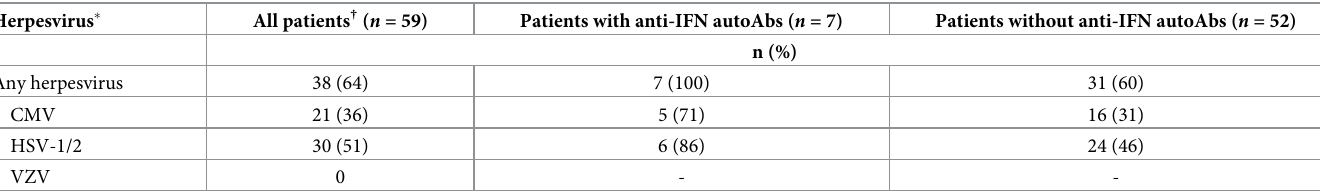
Table 3. Description of herpesvirus detection. Herpesvirus � All patients † ( n =